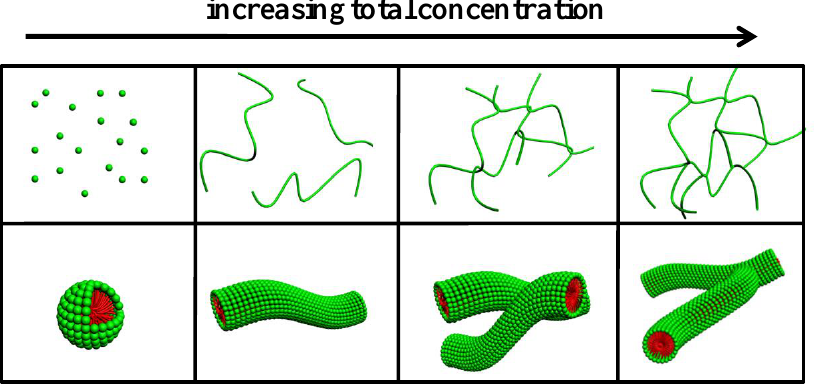
Figure 8. Model of aggregate transition with increasing concentration at X g = 0.30 and pH 6.7.